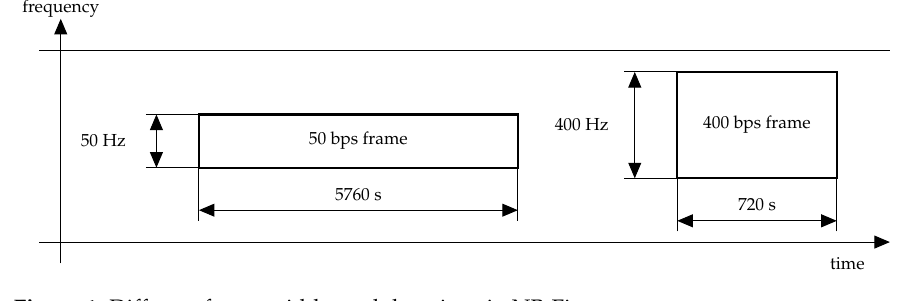
Figure 1. Different frame widths and durations in NB-Fi.